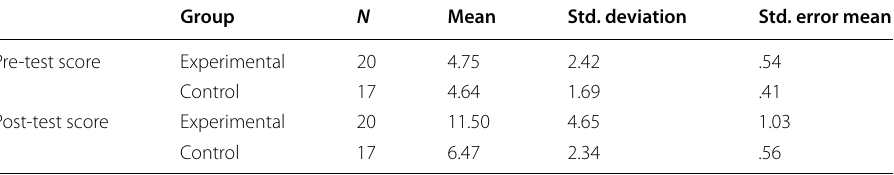
Table 2 Group statistics